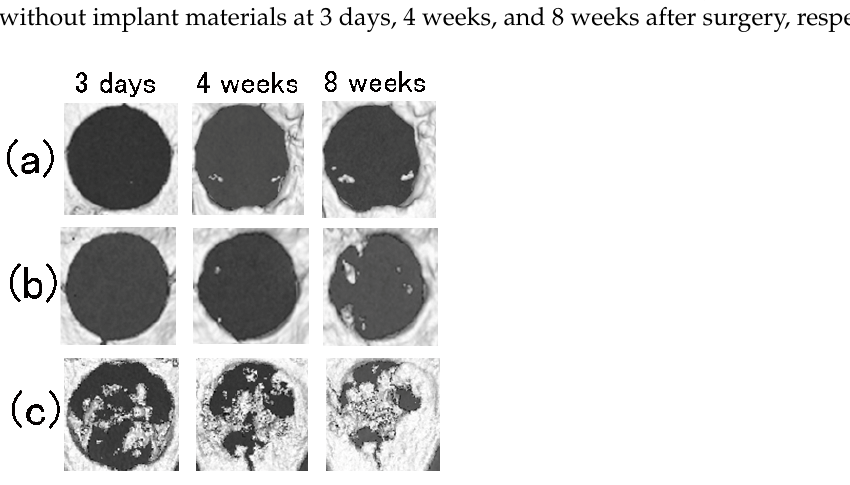
Figure 3. SEM photographs of pressed collagen (P-COL) and pressed nano-hydroxyapatite/collagen (P-nHAP/COL) (( a ): P-COL at low magnification (×500), ( b ): P-COL at high magnification (×20,000), ( c ): P-nHAP/COL at low magnification (×500), and ( d ): P-nHAP/COL at high magnification (×20,000)).